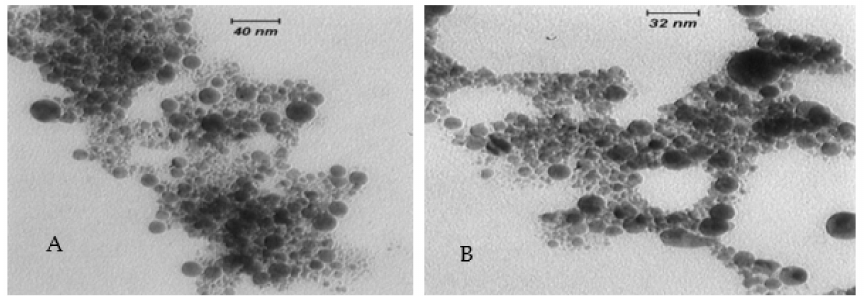
Figure 14. Transmission electron microscopy images of spherical-shaped Pt nanoparticles in ( A ) water and ( B ) methanol under the influence of a magnetic field. Adapted with permission from Ref. [177]. Copyright 2016, Sphinx Knowledge House.